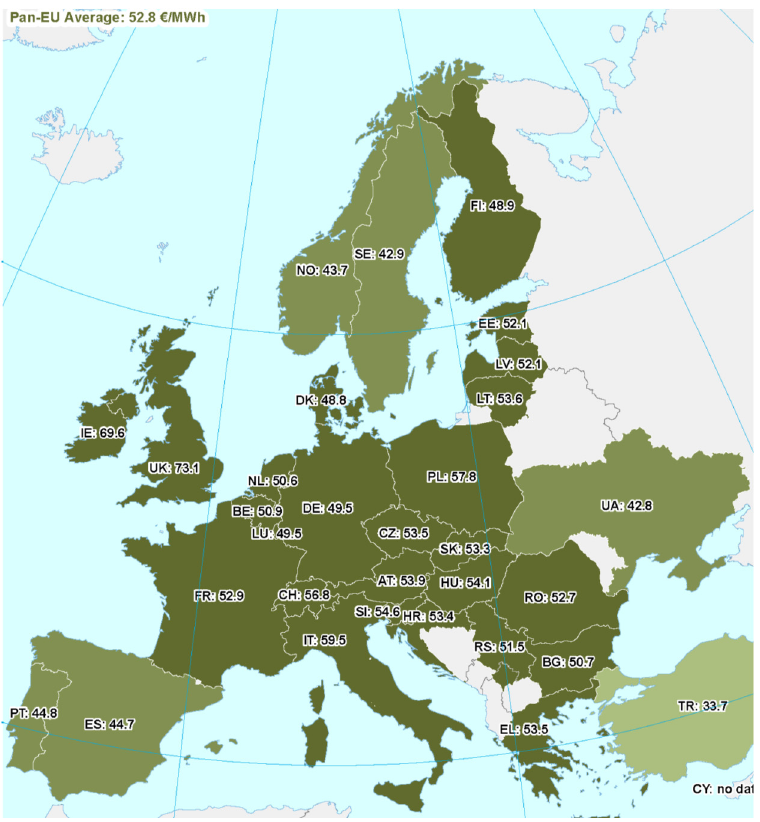
Figure 2. Average wholesale electricity prices, for the first quarter of 2021.